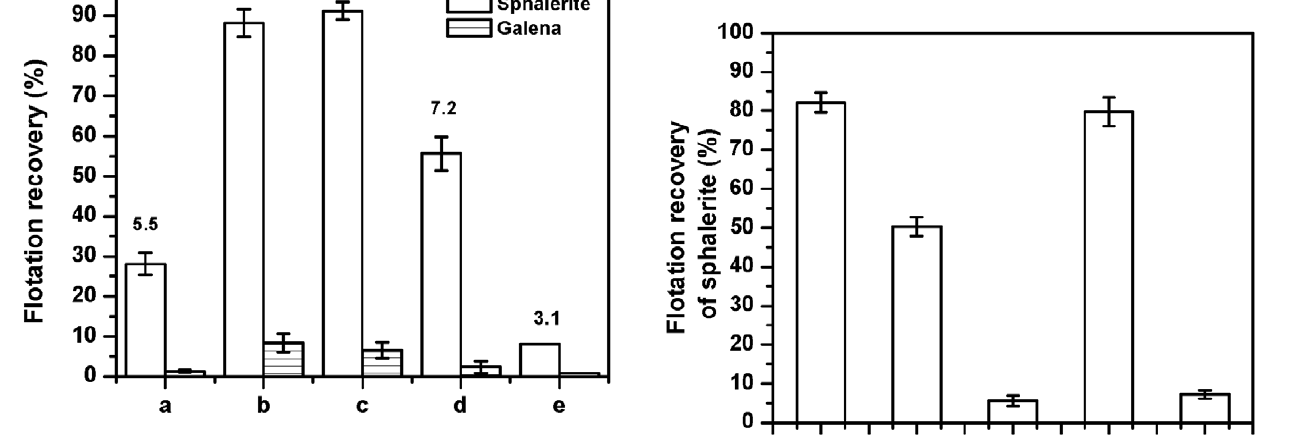
Figure 3. Selective flotation of sphalerite and galena in the presence of unfractionated or thermolysed and fractionated components of B.circulans. a - normal cells; b - thermolysed cells; c - thermolysed cell-free supernatant; d - thermolysed cell pellet; e – DNase 1 treated thermolysed cell-free supernatant. The numbers above the bar chart indicates the selectivity index (S.I) values.